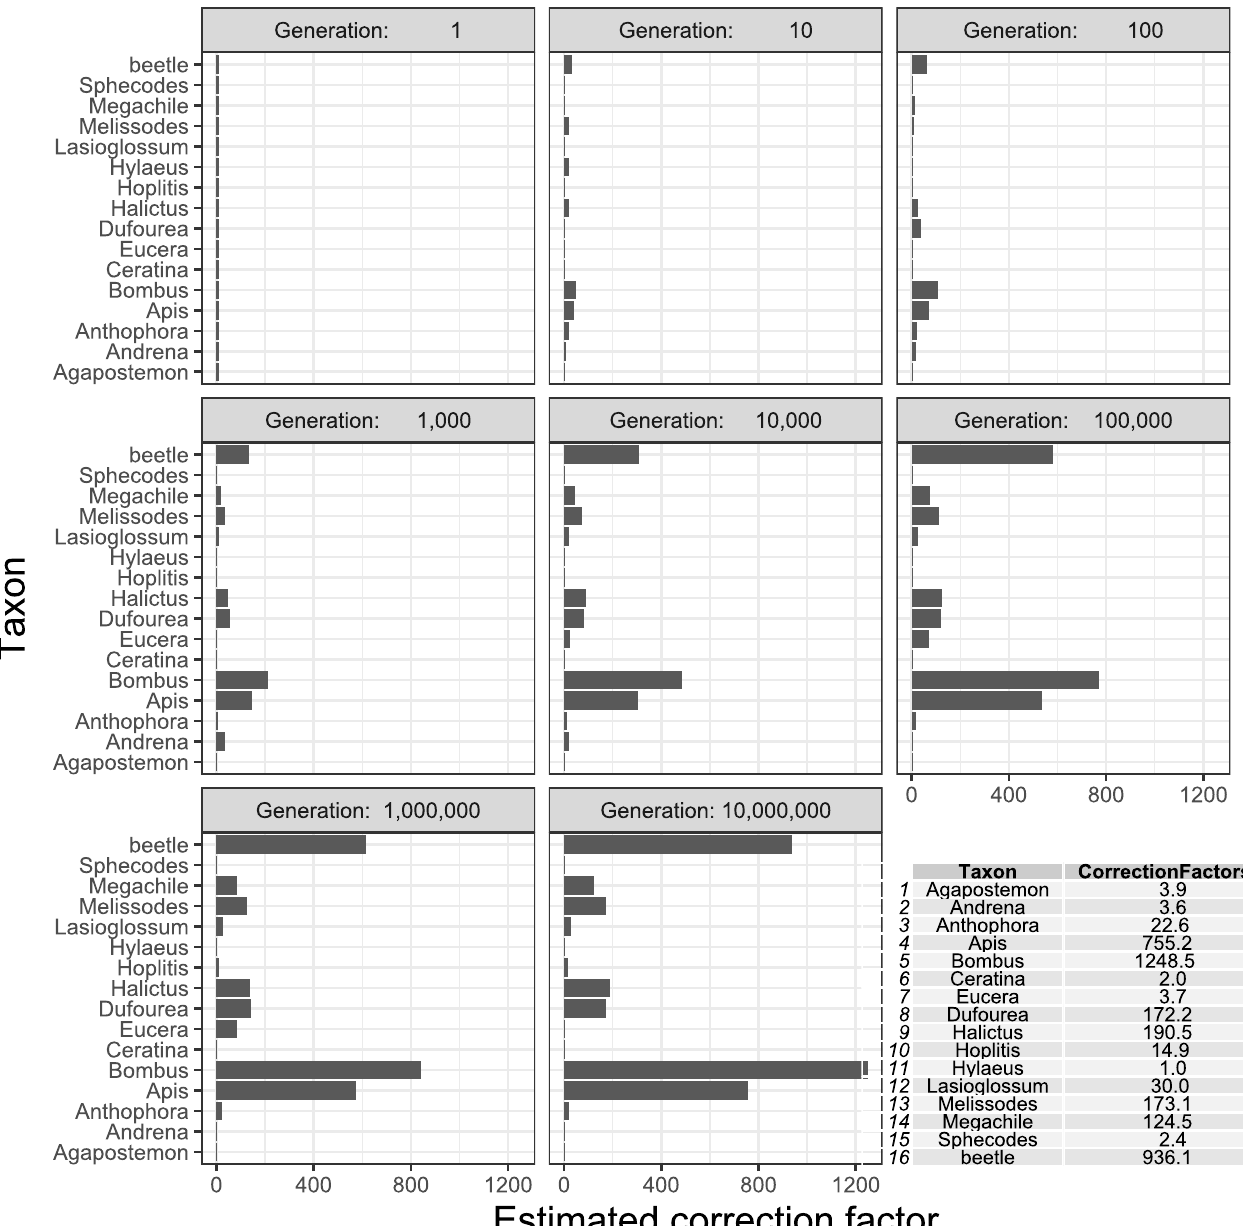
Fig 4. Results of correction factor genetic algorithm. The top copy number correction factor estimates (horizontal axis) is plotted for each taxon (vertical axis) after eight logarithmically spaced generations of the genetic algorithm (panels). Inset: tabular summary of the final correction factor estimates for each